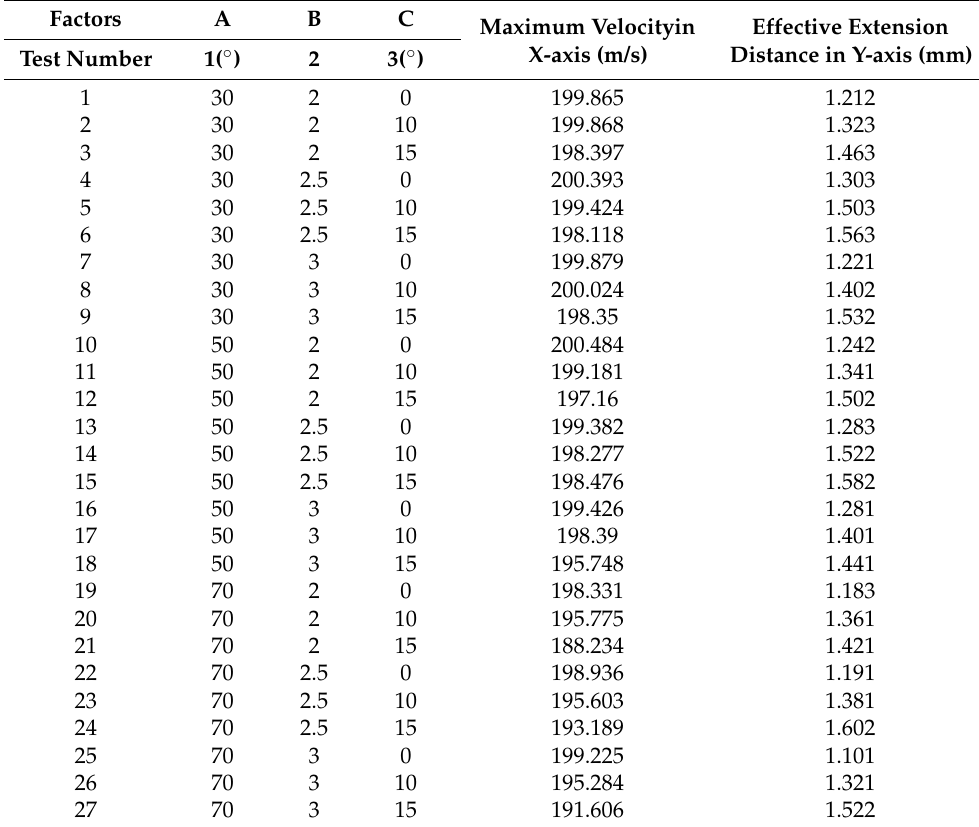
Table 4. Orthogonal test